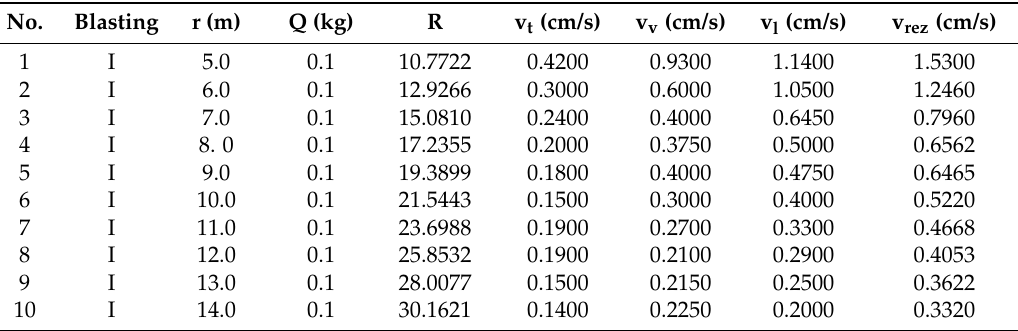
Table 1. Survey of blasting parameters and measurement results in the Veliki Krivelj Open